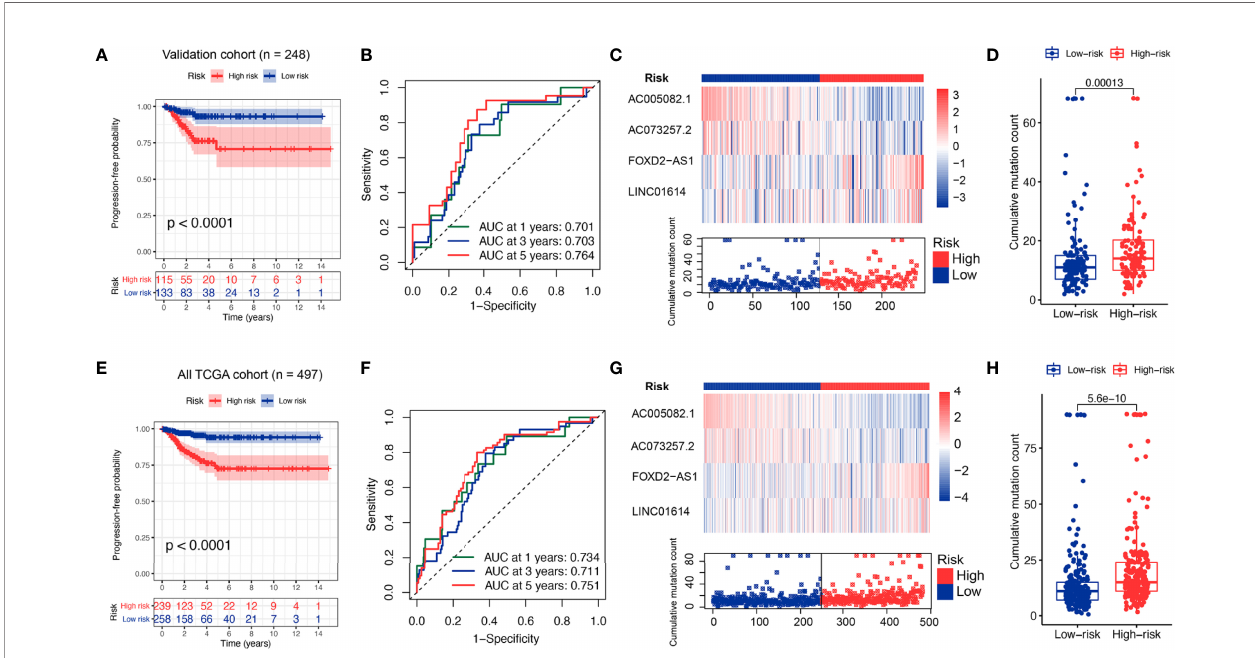
FIGURE 4 | Performance evaluation of the GILS in the whole TCGA set and validation set. Kaplan – Meier curves, ROC analysis of PFS, expression of individual lncRNA as well as somatic mutations in GU- and GS-like group predicted by GILS in the validation set (A – D) and all TCGA set (E – H) . Statistical analysis was performed using the log-rank test and Cox hazards regression analysis. PFS, progression-free